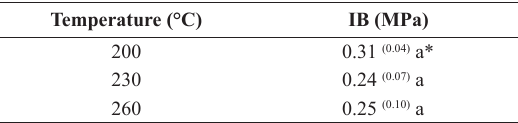
Table 10. Average values of internal bond as a function of